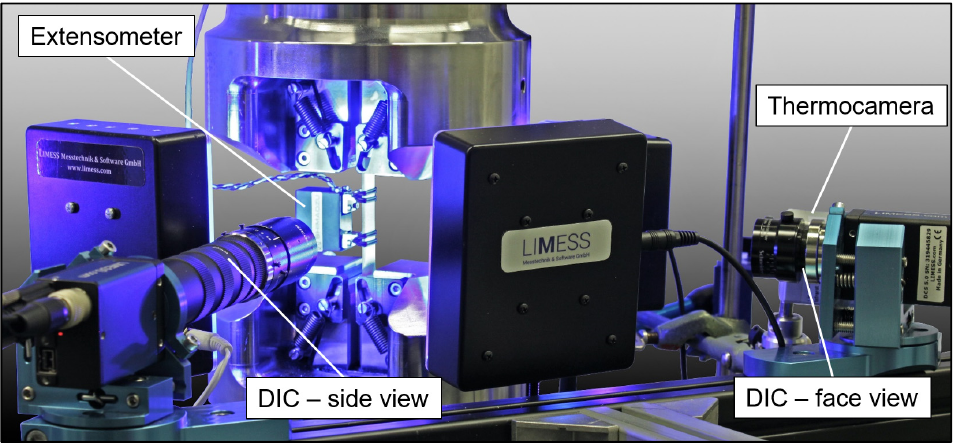
Figure 3. Experimental setup containing a servo-hydraulic testing system, digital image analysis cameras perpendicular to the specimen (face and side view), thermocamera, and tactile extensometer.